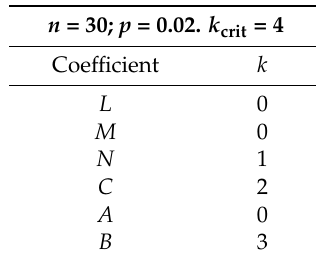
Table 3. Observed values of k considering only the middle troposphere between the 700 mb and 200 mb pressure